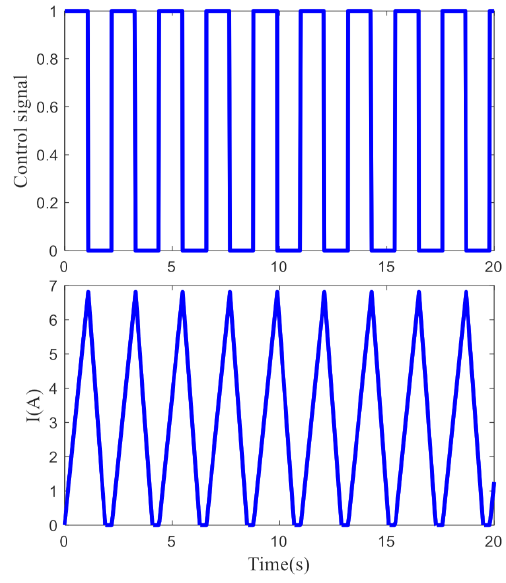
Figure 10. Control signal and current